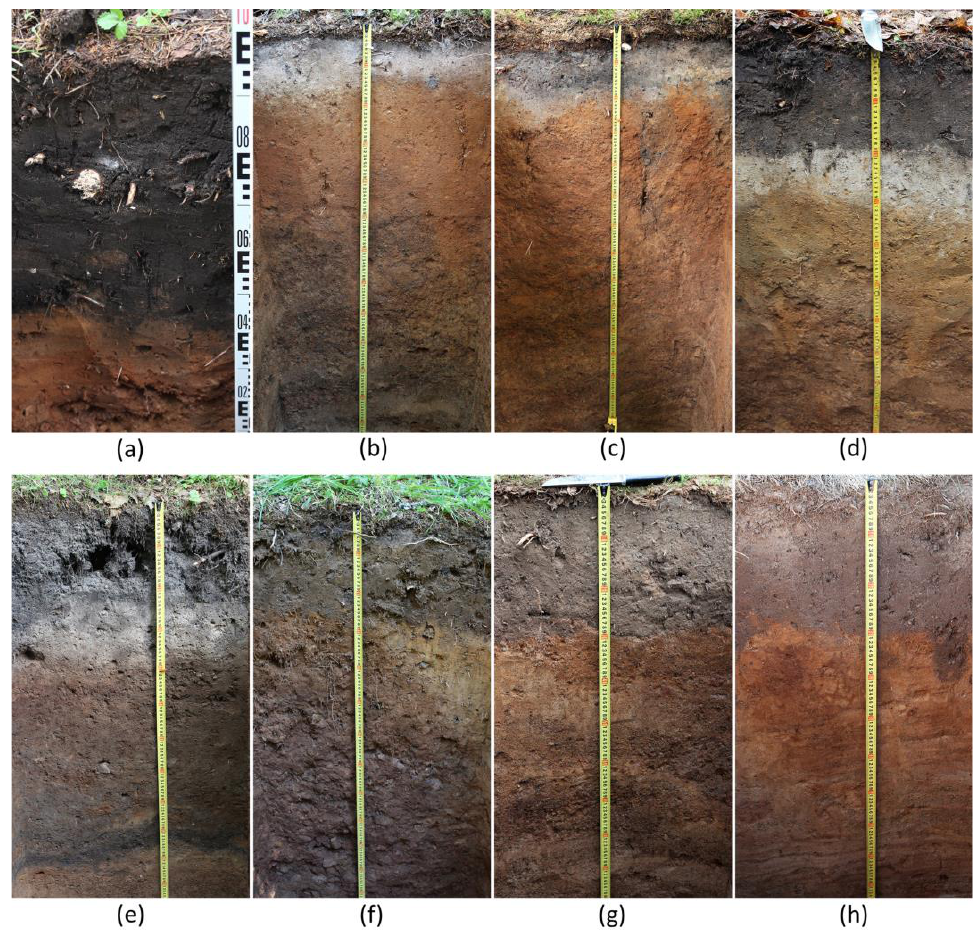
Figure 2. Soil profiles in different land types: hillforts — ( a ) V24; forest soils — ( b ) ZL18, ( c ) ZL31, ( d ) Zl40; sediments below hillforts — ( e ) V29; sediments below slopes in the forests — ( f ) KB23; arable lands — ( g ) ZL26; vegetable gardens — ( h ) ZL35.